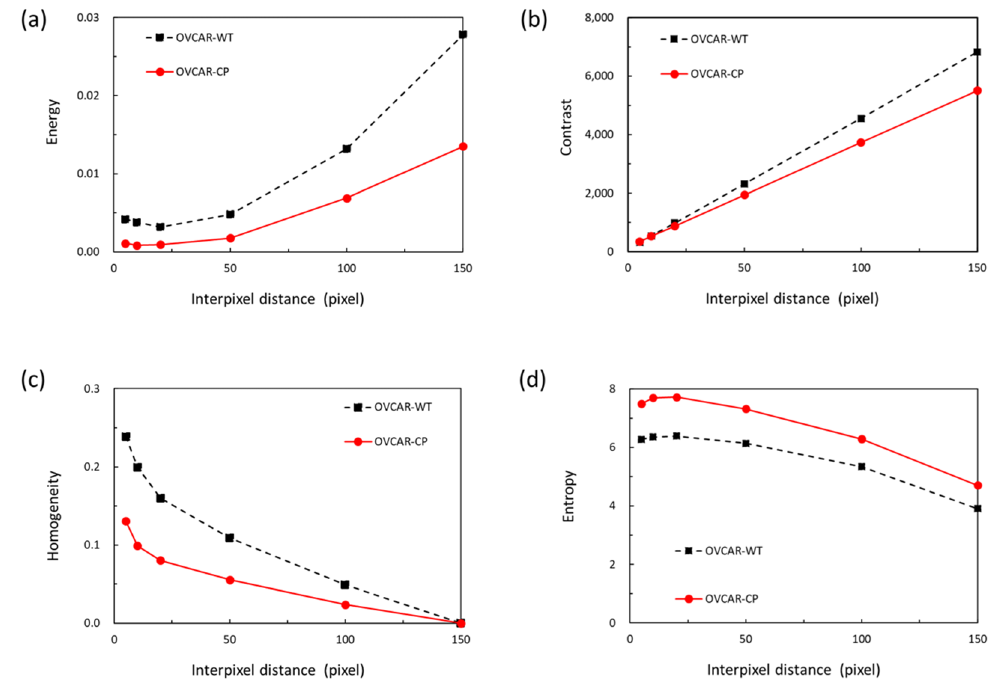
Figure 2. Gray level co-occurrence matrix (GLCM) texture feature: ( a ) energy, ( b ) contrast, ( c ) homogeneity, and ( d ) entropy for serous type (OVCAR-4) of ovarian adenocarcinoma cells with various interpixel distance with wild type (WT) and chemoresistance for cisplatin (CP). Texture feature of GLCM extracting for WT and CP-resistant ovarian adenocarcinoma cell images are shown in Table 1. The texture features of WT ovarian adenocarcinoma cells were used as the benchmark and statistically compared with those of the CP-resistant cells for OVCAR-4, A2780, and IGROV-1, respectively. In general, the results show that for each of the cell lines, the CP-resistant texture features of WT and CP-resistant ovarian adenocarcinoma cells for OVCAR-4, A2780, and